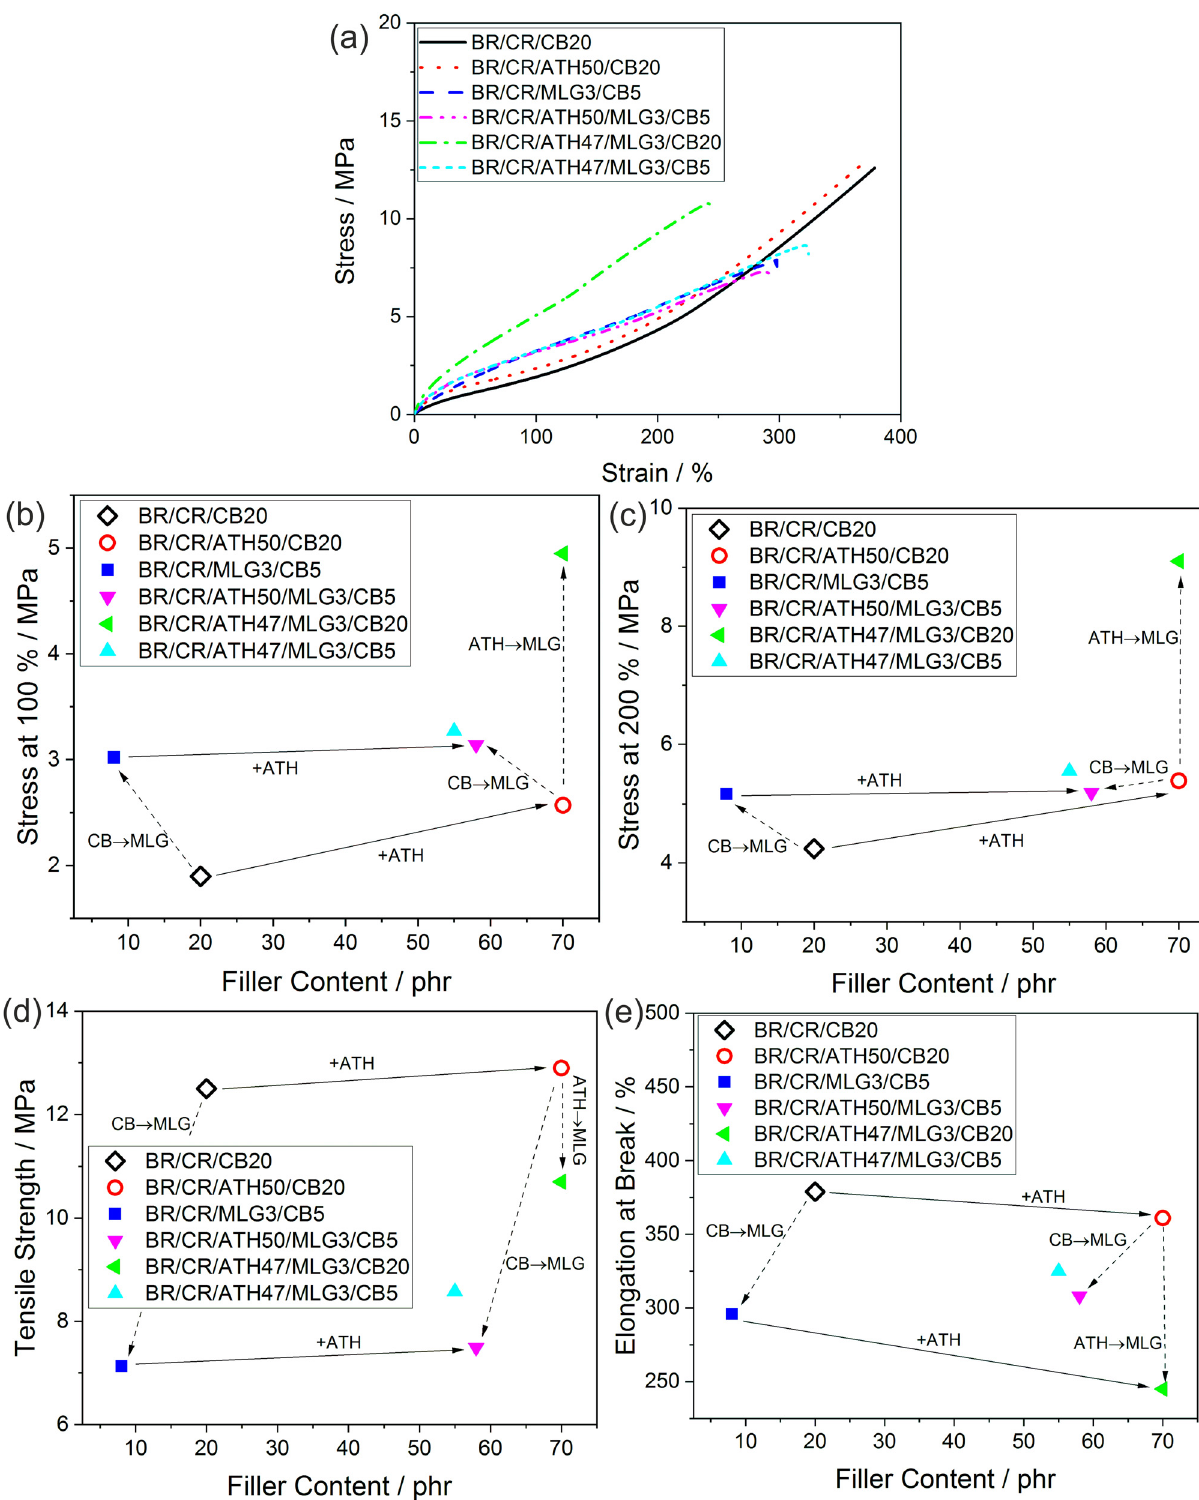
Figure 6: Results from tensile tests of cured BR/CR rubber composites; ( a ) tensile stress vs strain curves, ( b ) stress at 100% elongation and ( c ) at 200% elongation vs fi ller content, ( d ) tensile strength and ( e ) elongation at break vs fi ller content. For b, c, d, and e: solid line is addition of 50 phr ATH, dashed line is the replacement of 15 phr CB with 3 phr MLG, or 3 phr ATH with 3 phr